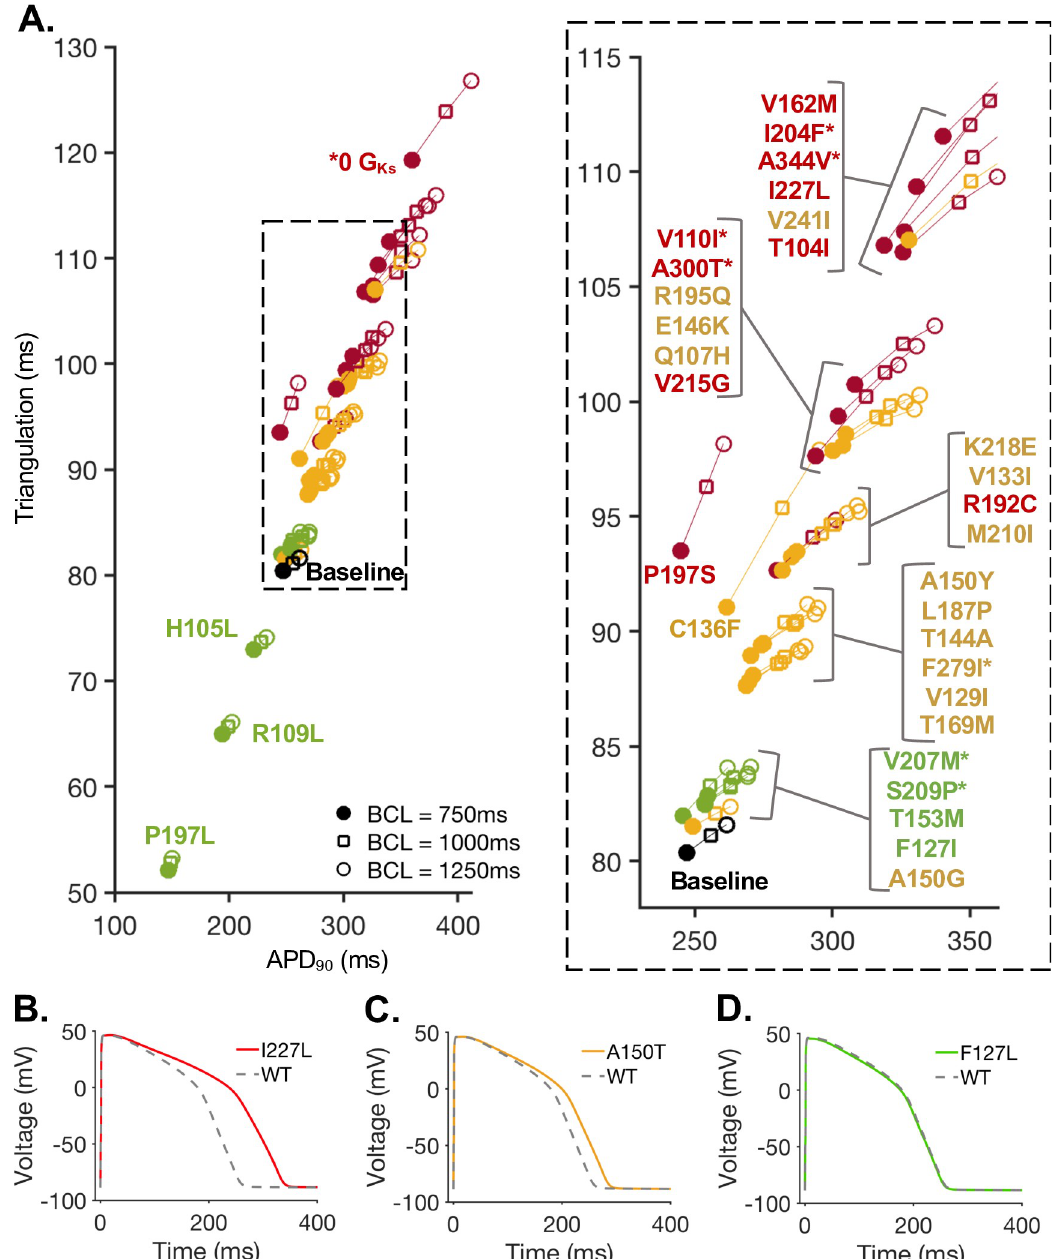
Fig 8. The predicted impact of I Ks mutations from test set 1 and test set 2 in the O’Hara- Rudy computational model of the adult ventricular cardiomyocyte. (A) Each mutated I Ks model was adapted for the adult ventricular cardiomyocyte model by incorporating relative changes in gating. APD 90 and triangulation of the Mann et al. optimization of the O’Hara-Rudy computational model of the adult ventricular cardiomyocyte with each mutant I Ks model is shown for three pacing rates with basic cycle lengths (BCL) or 750 ms, 1000 ms, and 1250 ms. Starred mutations ( � ) are from test set #1 (TS1), remaining mutations are from test set #2 (TS2). The color of each mutation is determined by the designated classifications in the iPSC-CM model populations, as shown for TS1 (Fig 3A) and TS2 (Fig 4A). (B) The adult ventricular cellular model AP for wild-type (grey, dashed) and I204F mutant (red) at cycle length (CL) 750 ms. (C) The adult ventricular cellular model AP for wild-type (grey, dashed) and A150T mutant (yellow) at CL = 750 ms. (D) The adult ventricular cellular model AP for wild-type (grey, dashed) and F127L mutant (green) at CL = 750ms.